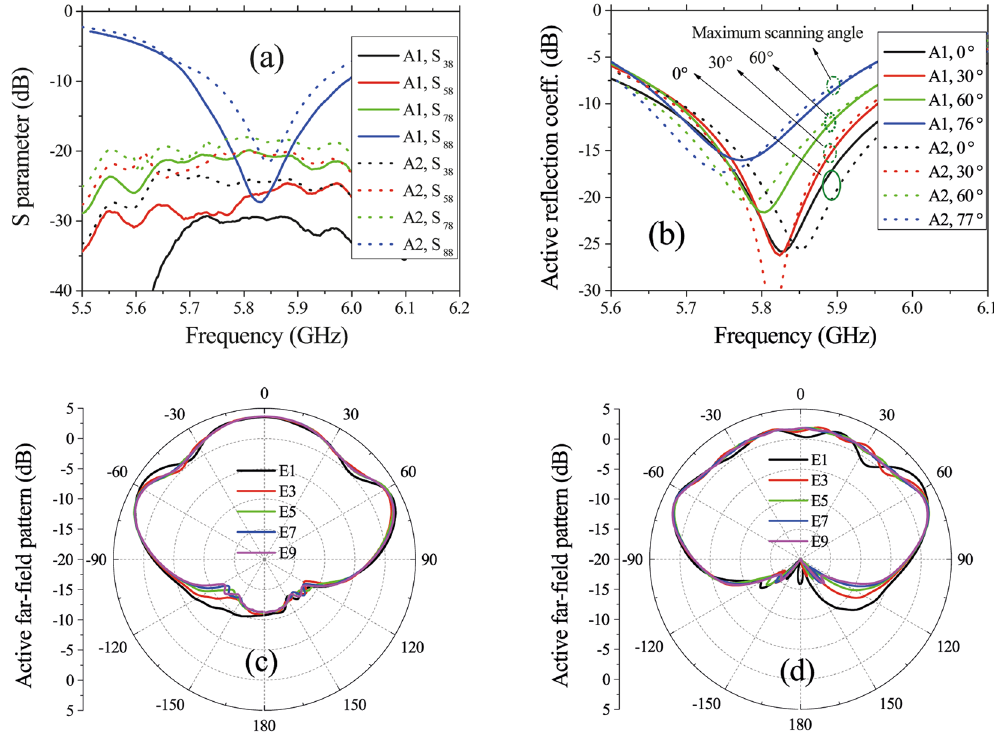
Figure 11. Active S parameters and patterns of the two linear arrays. ( a ) Measured S parameters when Element 8 is excited. ( b ) Active reflection coefficients of Element 8 corresponding to different scanning angles. The active reflection coefficients in the band of 5.73 GHz–5.85 GHz of both the two arrays are below − 10 dB in all the scanning status. ( c , d ) are measured active patterns in the xz plane of A1 ( c ) and A2 ( d ). E1~E9 represent Element 1~Element 9,